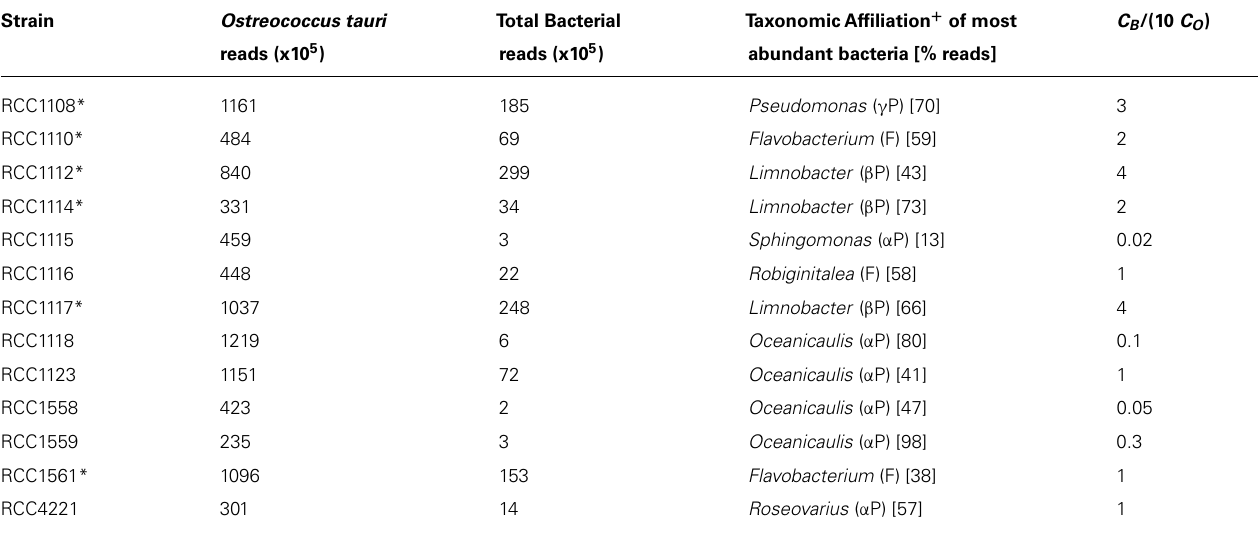
Table 2 | Number of reads assigned to Ostreococcus tauri and bacteria for each cultured strain and estimation of the number of bacterial cells for 10 O. tauri cells from Eqn (2) for the most abundant bacteria. Strain reads (x10 5 )